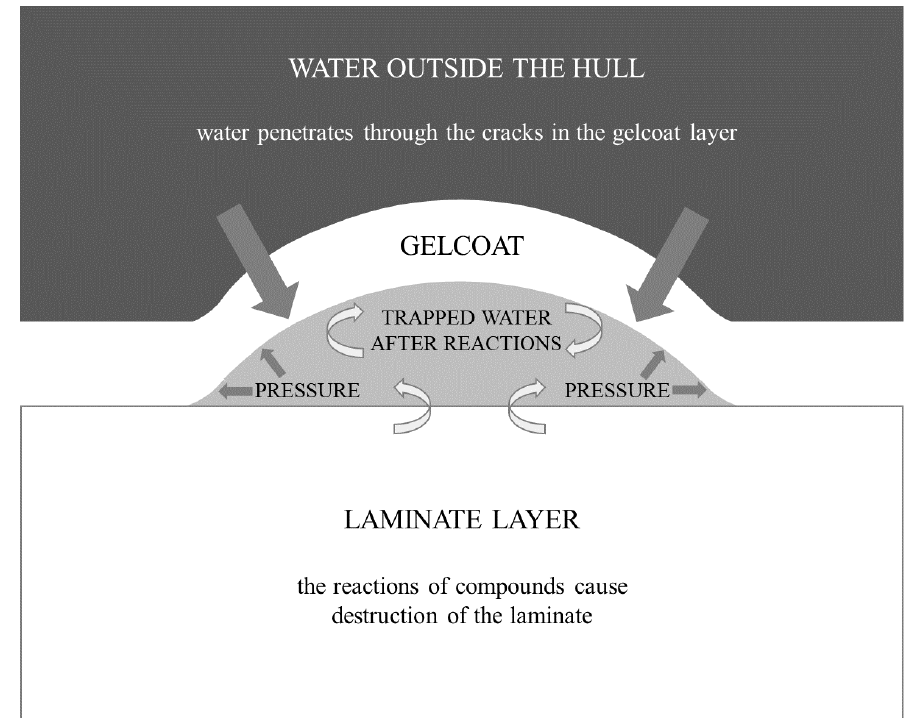
Figure 1. The process of the osmosis phenomenon